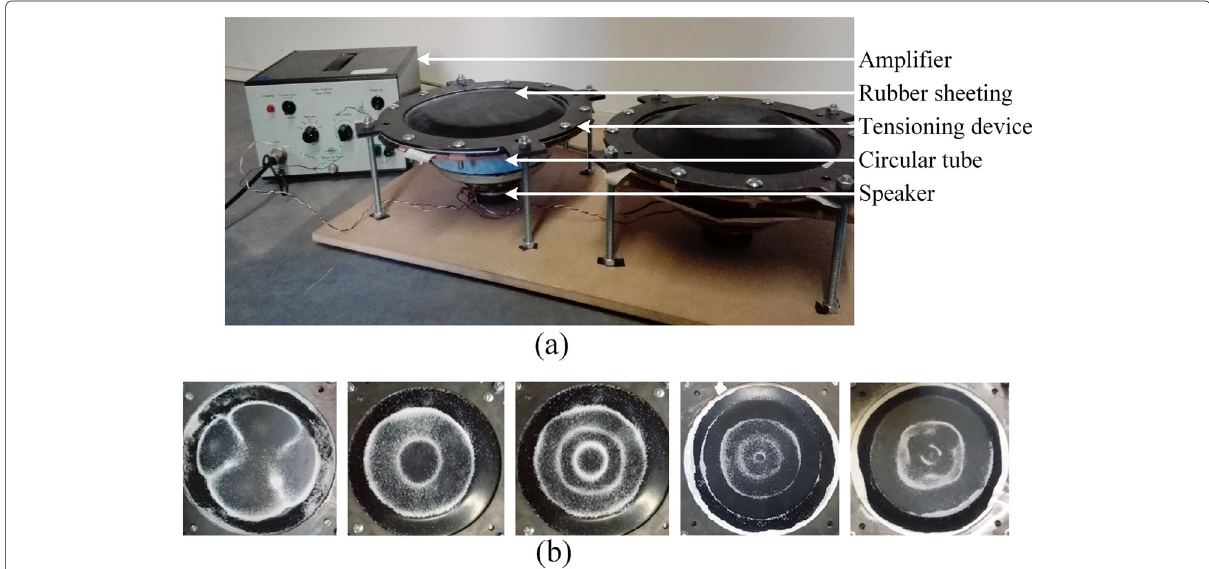
Fig. 1 a Rubber sheets are tensioned over circular tubes and excited with speakers which are placed underneath the tubes. b The sound frequency is varied, and the salt is used to visualise the mode